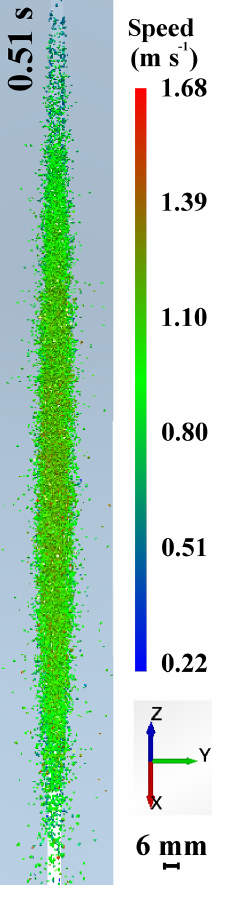
Figure 7. Fully developed shape of travel of a granular flow seen from above 0.51s after the gate removal. In this example, the gran- ular mass is 26g, the grain size is 1mm, w is 6mm and θ is 27 ◦ .